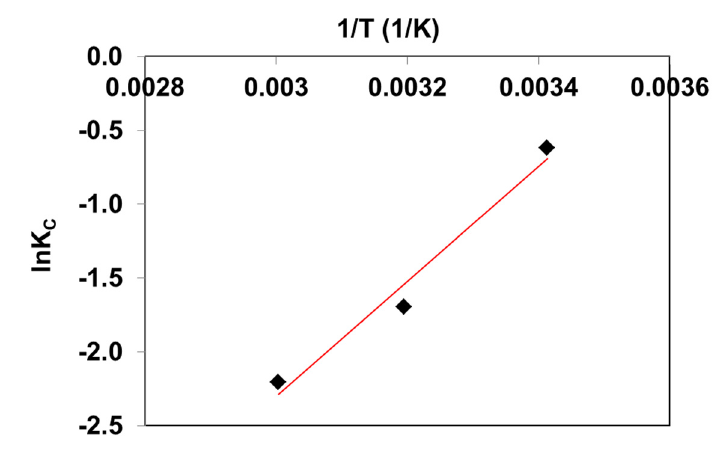
Figure 3. 1/ T dependency of ln K C for BR46 uptake by C/SiO 2 Figure 3. 1 / T dependency of ln K C for BR46 uptake by C/SiO 2 composite. The negative values of free energy were found to be − 15 kJ/mol, − 14 kJ/mol and − 13